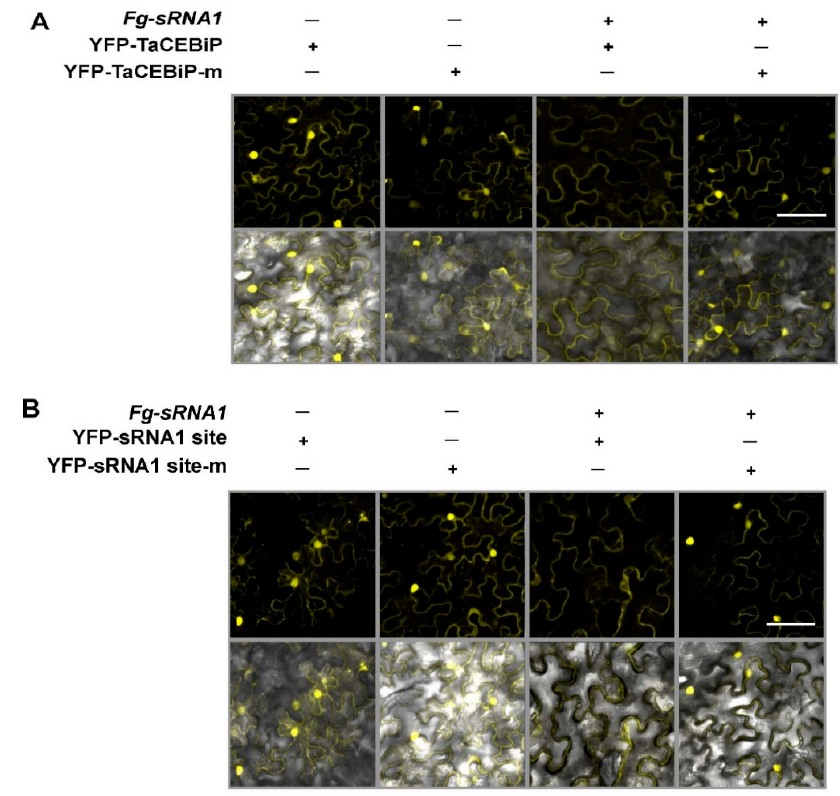
Figure 7. Suppression of YFP – tagged TaCEBiP co-expressed with Fg-sRNA1 . ( A ) Co-expression of YFP-TaCEBiP or its synonymously mutated version (YFP-TaCEBiP-m) with Fg-sRNA1 were observed with confocal microscopy; and ( B ) Expression of the YFP sensors carrying a Fg-sRNA1 target site of TaCEBiP or a Fg-sRNA1 target site-m, were analyzed after co-expression of Fg-sRNA1 . Samples were examined at 48 h after transiently Agrobacterium -mediated transformation into N. benthamiana leaves. ( Top ) YFP. ( Bottom ) YFP/bright field overlay. Scale bar is 50 μ m. Similar results were obtained in three biological replicates.